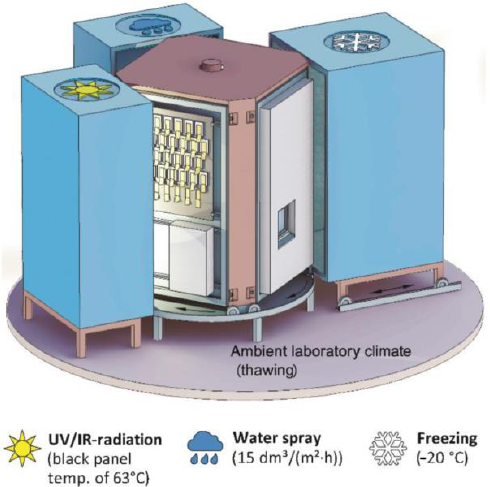
Figure 1. Climate simulator with four climate zones used for testing according to NT Build 495 as illustrated by Kvande et al. [6]. The mid-section is rotating